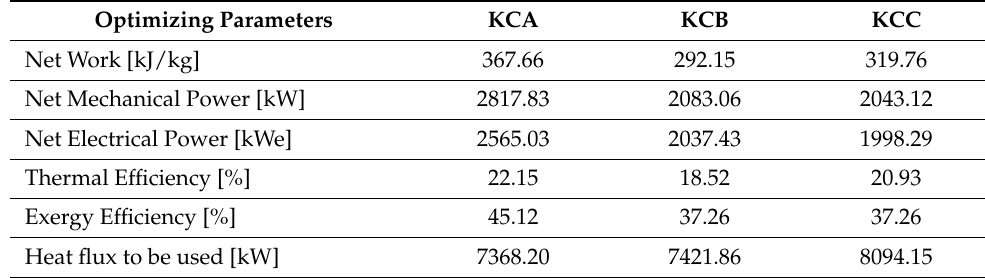
Table 7. Performance study parameters of the three cycles